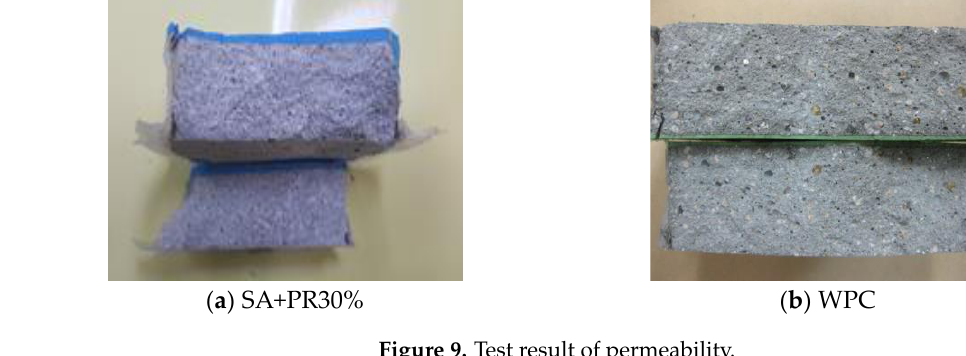
Figure 10. Test result of abrasive wear resistance. ( a ) Collection for depth measurement. ( b ) Surface thickness difference before and after the test in SA+PR30%. ( c ) Surface thickness difference before and after the test in WPC.